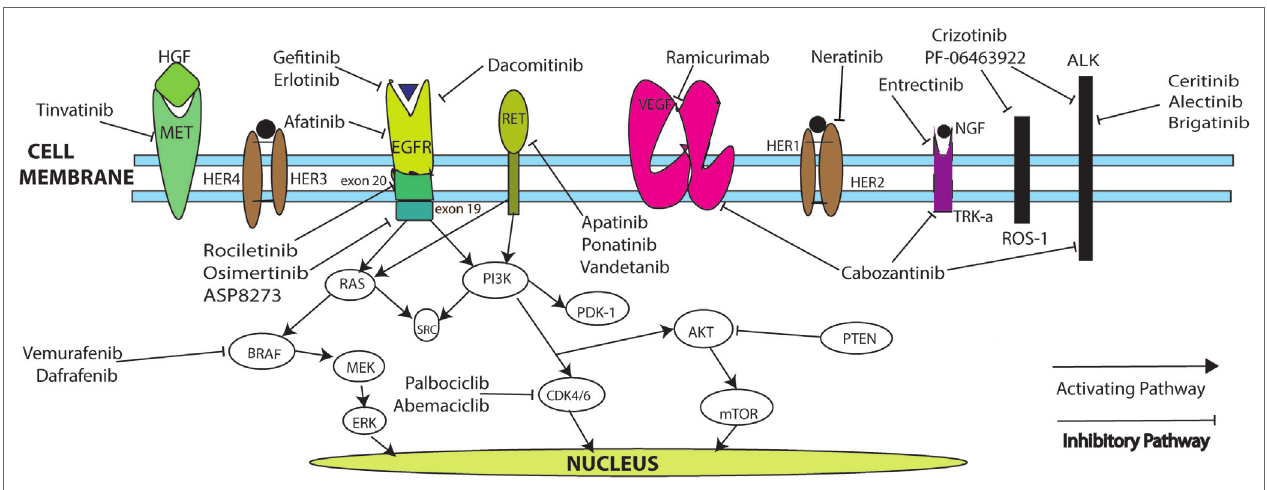
FiGURe 1 | Targeted pathways for